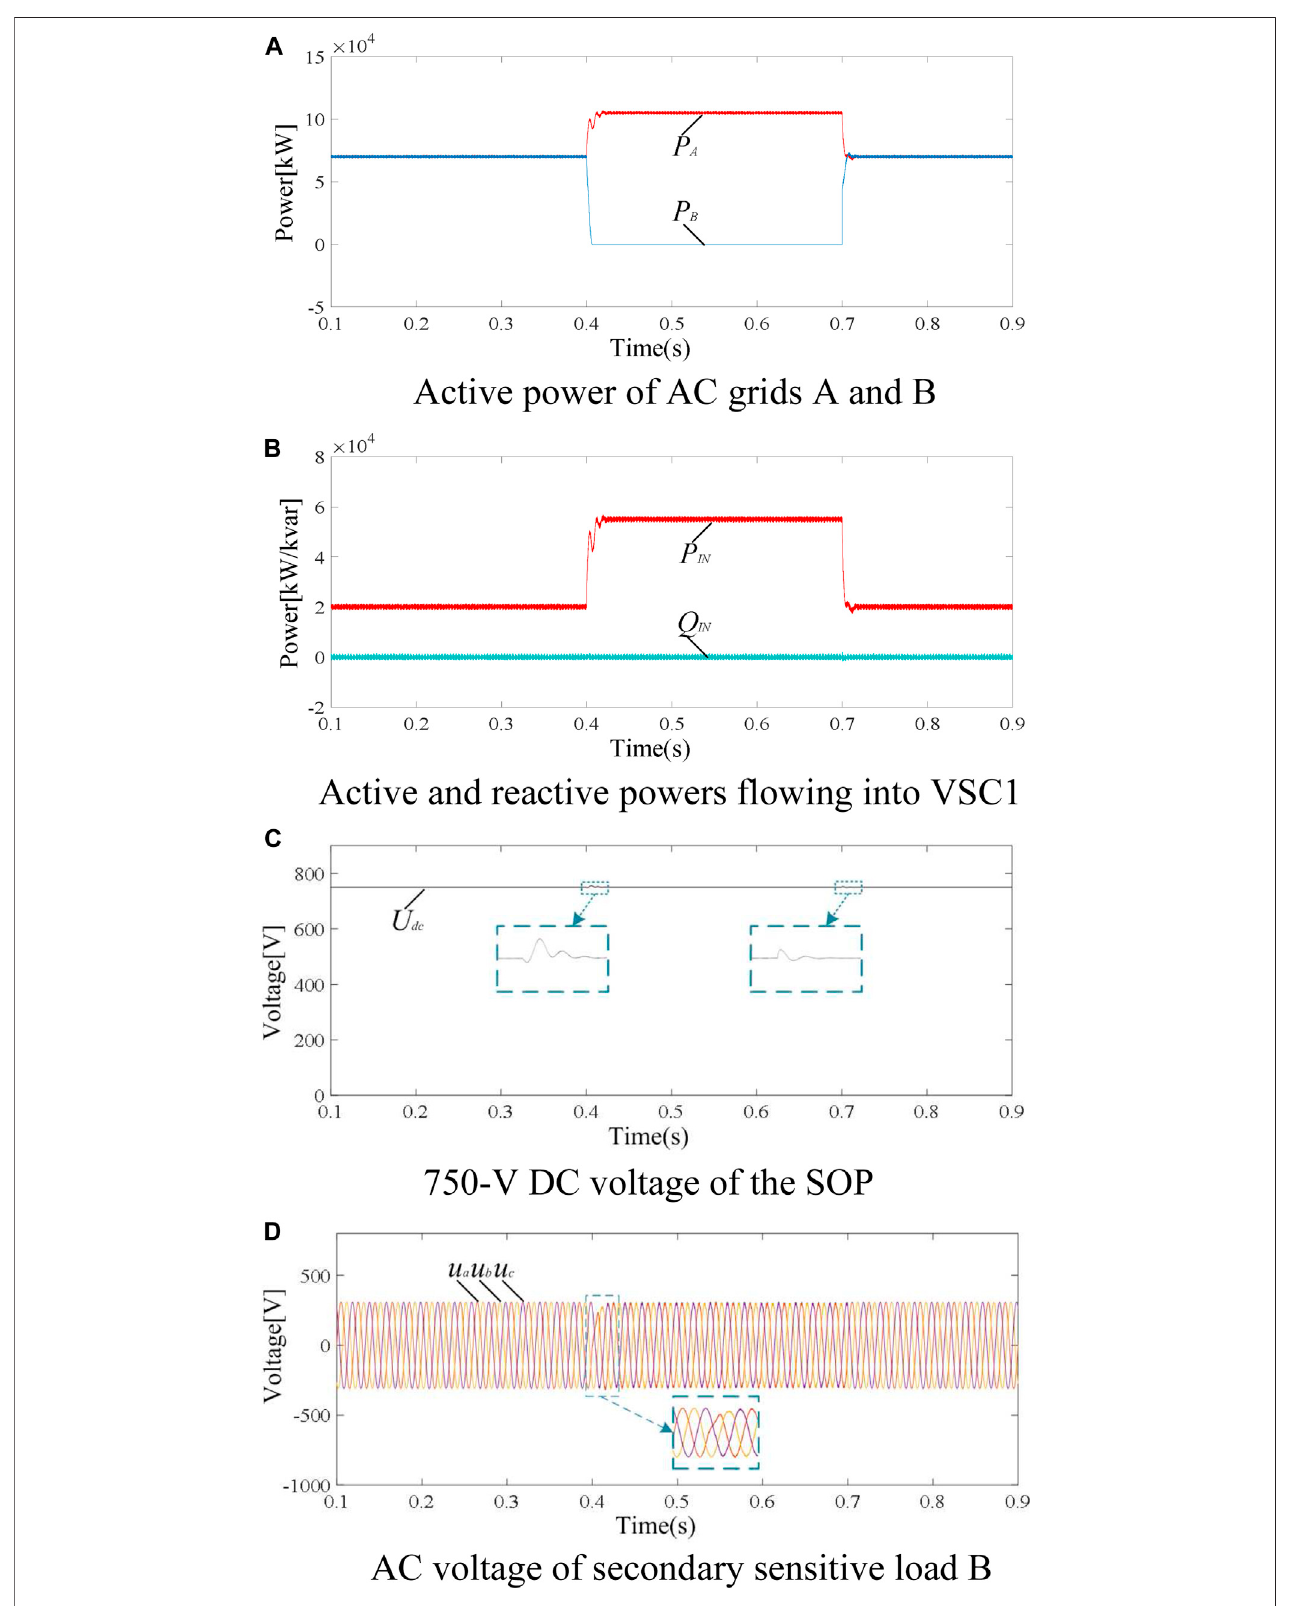
FIGURE6| ACgridfaultsimulationresults (A) ActivepowerofACgridsAandB (B) Activeandreactivepowers fl owingintoVSC1 (C) 750 VDCvoltageoftheSOP (D) AC voltage of secondary sensitive load B.